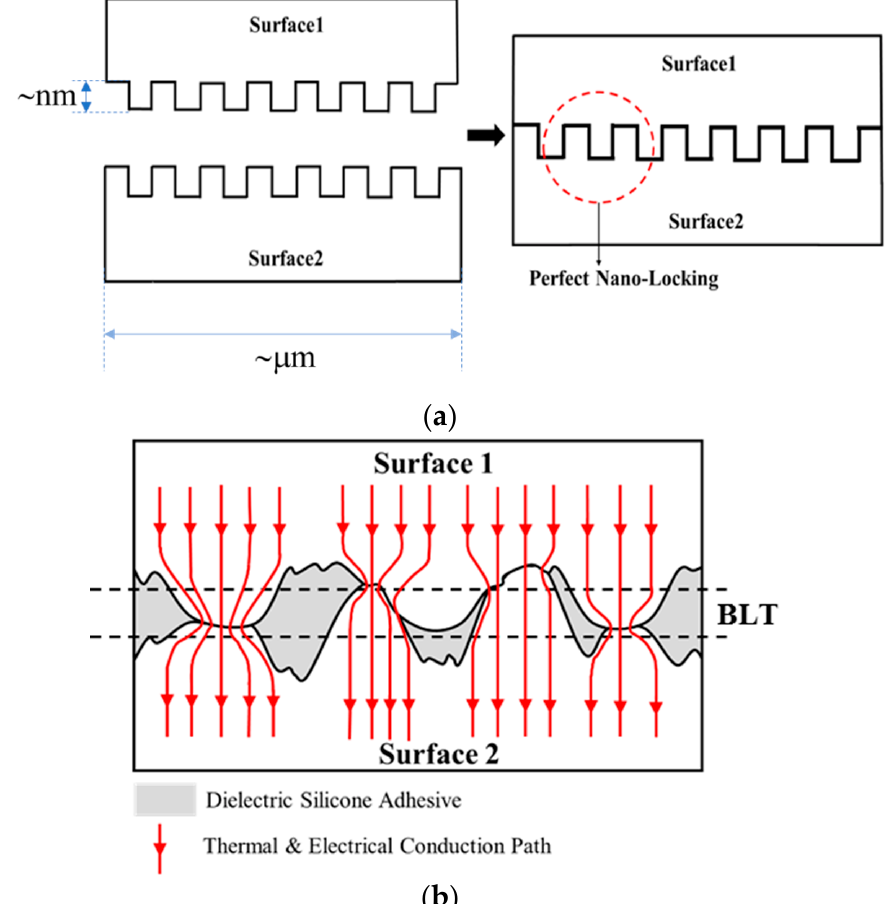
Figure 1. Schematic illustration of the nano-locking (NL) method for chip interconnection and bonding: ( a ) a perfect locking for two surfaces with exact matching structures and ( b ) a locking for general interconnecting surfaces with random intrinsic structures: electrical and thermal interconnections are established (the indicated pathways) when the surfaces are in contact, and the interconnection is stabilized and the two surfaces are bonded by the adhesive filled in the surface valleys (the gray area).